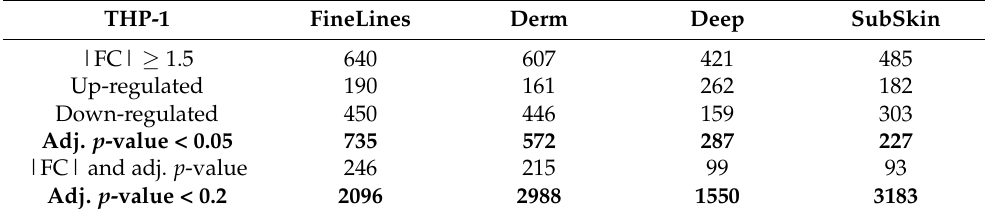
Table 2. Differentially expressed genes (DEGs) for M0 macrophages derived from THP-1 cells exposed to Perfectha ® filler extracts. The number of genes significantly different compared to non-treated control cells is indicated in bold. THP-1 FineLines Derm